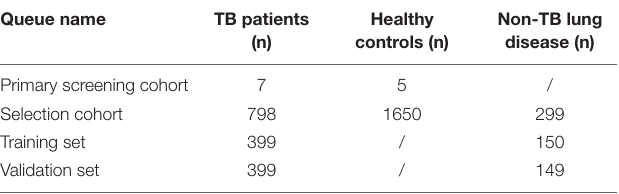
TABLE 1 | Cohort distribution of PTB population